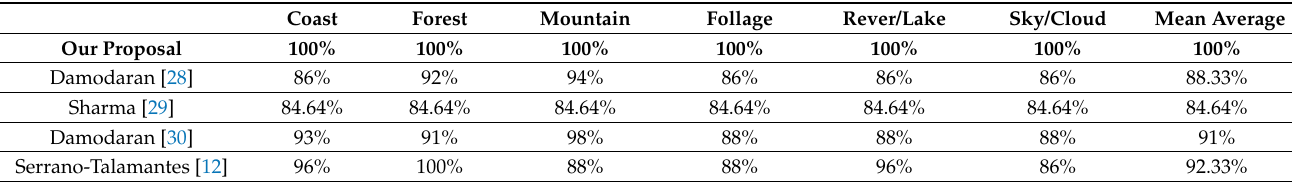
Table 5. Detection performance of the most competitive methods in natural image recognition using the same databases